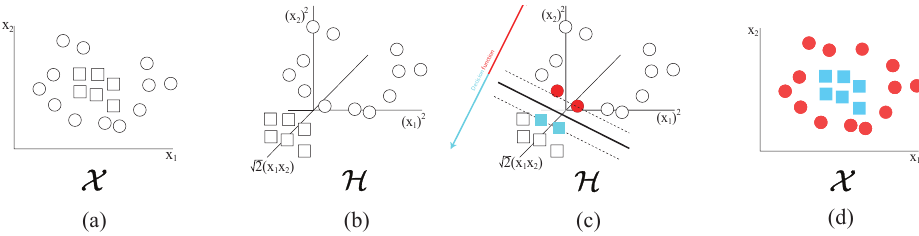
Figure 5. Illustration of the nonlinear SVM. (a) A nonlinearly separable data set in the input space X , involving two classes (squares and circles). (b) Projection on a 3-D space H by the kernel K( x i , x j ) = h x i , x j i 2 . (c) Linear classification in the projected space H (filled dots are support vectors). (d) Corresponding nonlinear decision function in the original space X . Adapted from Volpi et al. (2013).